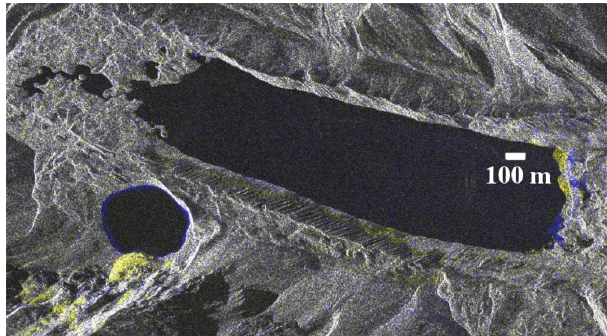
Fig. 9. Colour composite of the TerraSAR-X acquisitions of 17 Oct 2009 (red and green = yellow) and 14 May 2010 (blue) of Imja Tsho in the original SAR geometry. Ground-resolution (i.e. pixel spacing) is on the order of